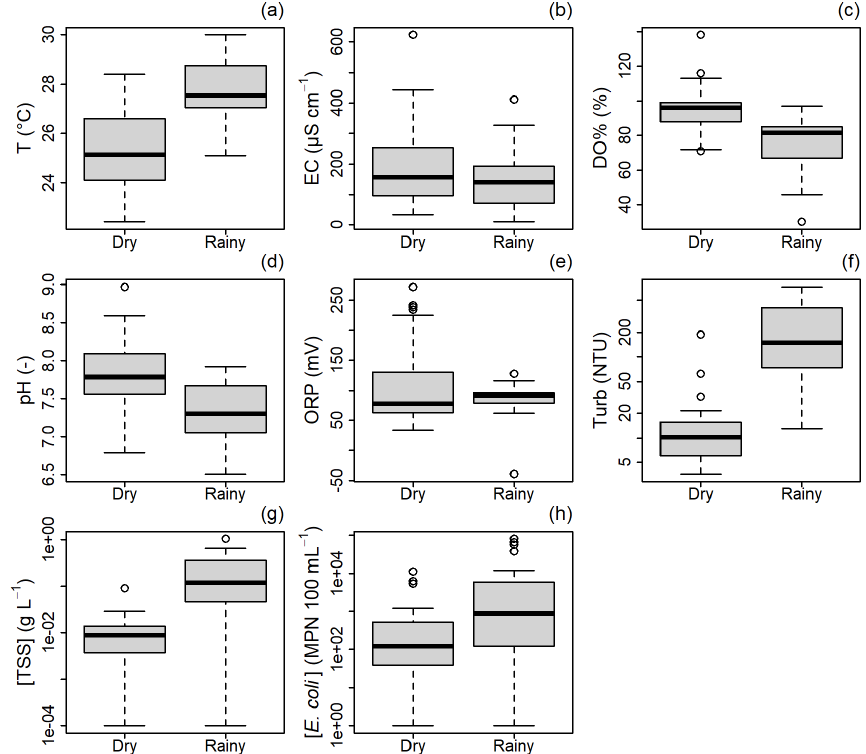
Figure 2. Stream water quality during dry and rainy seasons in 2016 along the Mekong River (six sampling stations) and in 19 of its tributaries (23 sampling stations) in Lao PDR. T : temperature ( ◦ C); EC: electrical conductance at 25 ◦ C (µScm − 1 ); DO%: oxygen saturation (%); pH: pH (–); ORP: oxidation-reduction potential (mV); Turb: turbidity (NTU); [TSS]: total suspended sediment concentration (gL − 1 ); [ E. coli ]: Escherichia coli concentration (MPN 100mL − 1 ). Turb, [TSS], and [ E. coli ] are shown with y axis as log scale. We added 0.0001 and 1 to all [TSS] and [ E. coli ] values, respectively, to present 0 values in a log scale, by